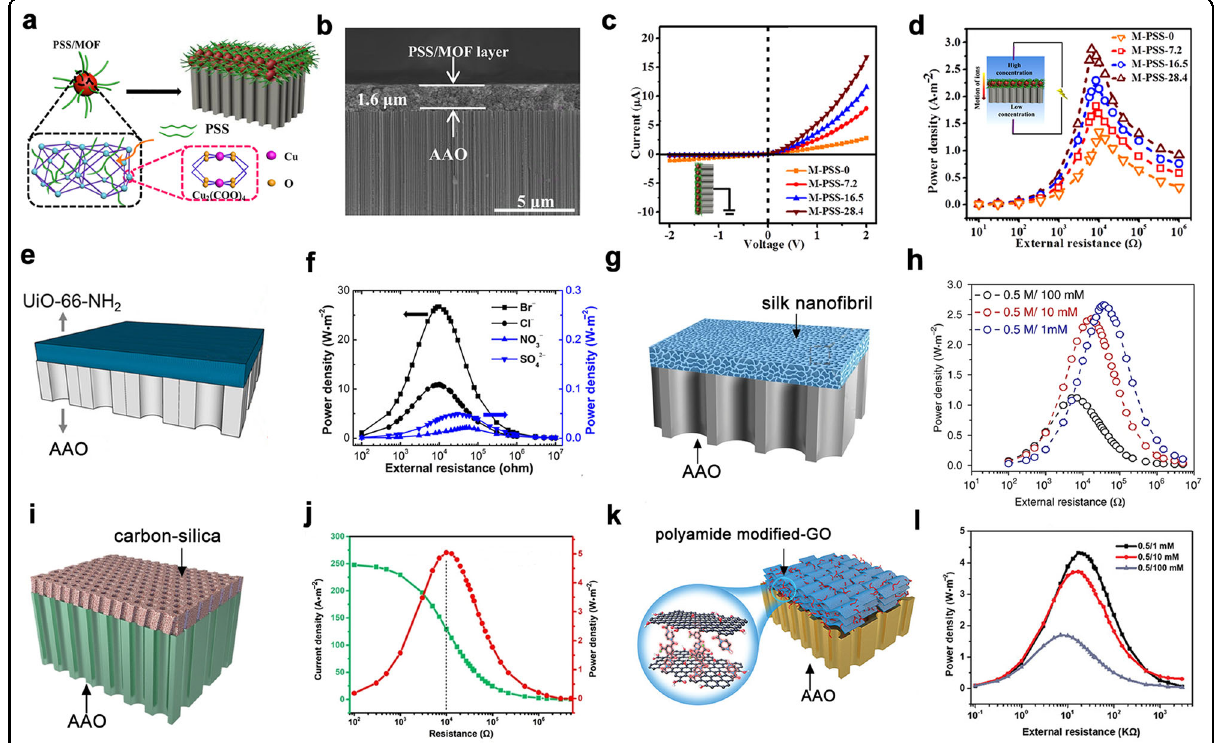
Fig. 5 AAO-supported hierarchical nanochannel membranes. a Schematic of a PSS/MOF nanochannel on an AAO support. b SEM image of the cross-sectional morphology of the PSS/MOF-AAO membrane. c I ‒ V curves of the membranes with various PSS contents in 10 mM KCl solution. d Output power density of the membranes along with different external resistances. Reproduced with permission 47 . Copyright 2018, Elsevier. Schematic of UiO-66-NH 2 -AAO ( e ), silk-AAO ( g ), carbon-silica-AAO ( i ), and PA-GO-AAO membranes ( k ) and their corresponding power density evaluation under different conditions ( f , h , j , l ). Panels e and f are reproduced with permission 49 . CC BY 4.0 (https://creativecommons.org/licenses/by- nc/4.0/). Panels g and h are reproduced with permission 29 . Copyright 2019, CC BY (https://creativecommons.org/licenses/). Panels i and j are reproduced with permission 31 . Copyright 2021, Wiley-VCH. Panels k and l are reproduced with permission 50 . Copyright 2021,